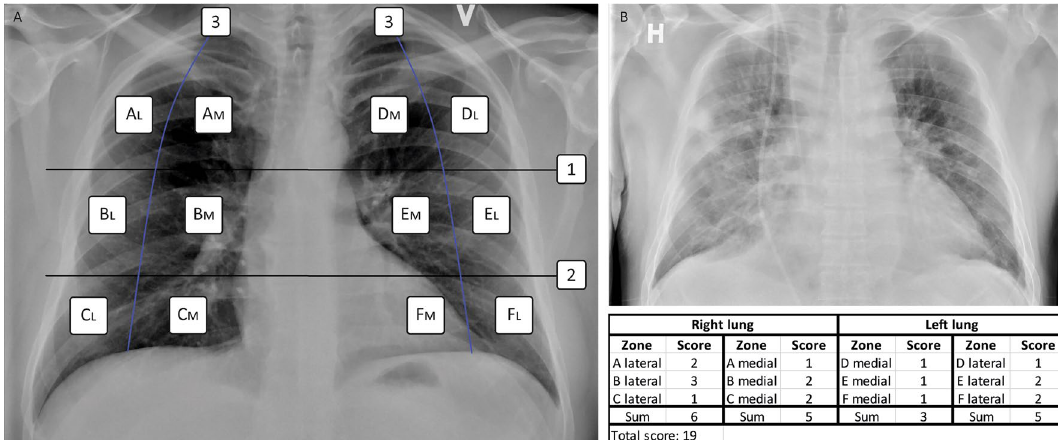
Figure 1. ( A ) The MBrixia scoring system. Box 1 and 2 mark the horizontal division corresponding to the inferior wall of the aortic wall, and the inferior wall of the right pulmonary vein, respectively, creating three zones in each lung: A, B, C, D, E and F. Box 3 marks the vertical line drawn from the pulmonary apices to the diaphragm, creating further division into medial (M) and lateral (L) zones. ( B ) A clinical example of a chest x-ray image scored using the MBrixia